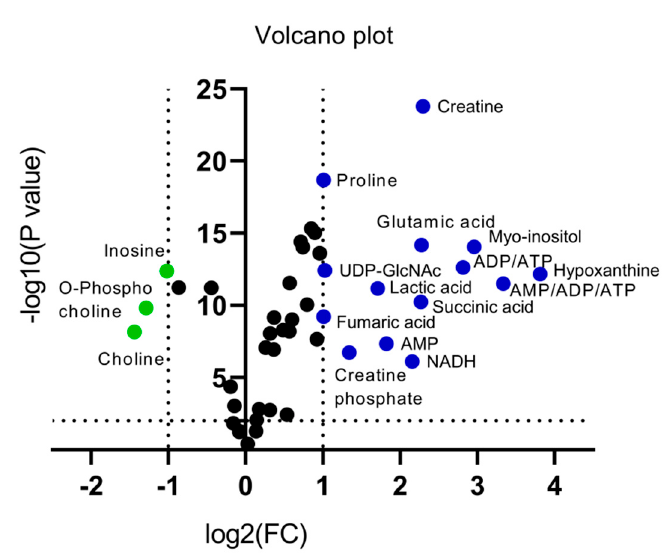
Figure 5. Volcano plot of human melanoma metabolites. Fold Change (FC) < 0.5, or Fold Change (FC) > 2 and p < 10 − 5 are observed for metabolites indicated in color.